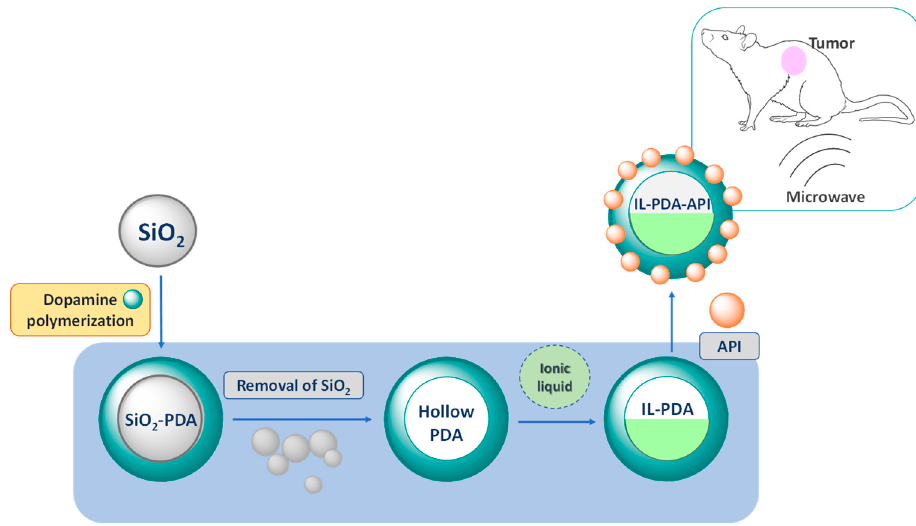
Figure 16. Schematic illustration of the preparation of IL-polydopamine (PDA) nanoparticles loaded with doxorrubucin for combined chemotherapy and microwave thermal therapy proposed in [181].